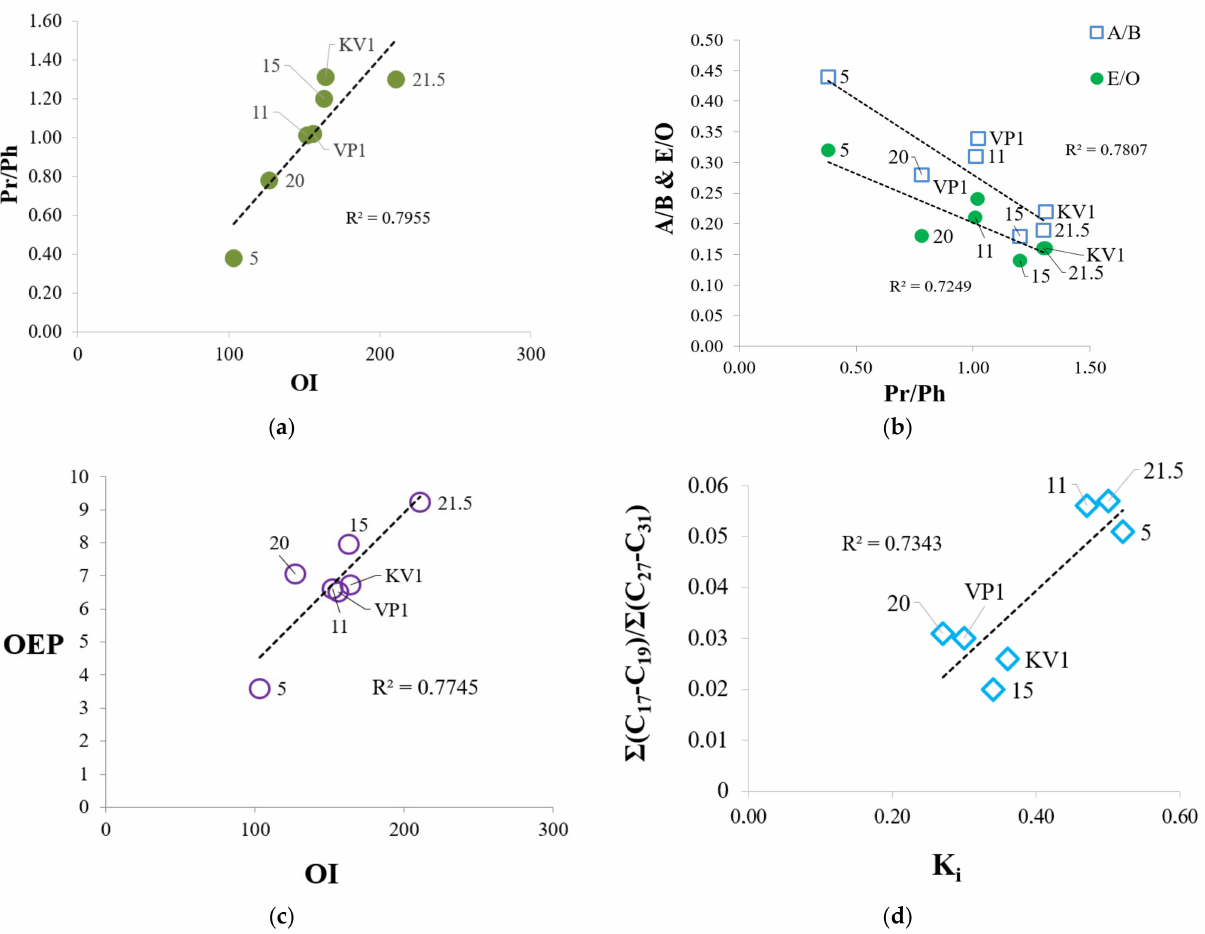
Figure 8. Relationships between Rock Eval parameters and biomarker coefficients determined from GC-MS analysis: ( a ) Relationship between OI and Pr/Ph; ( b ) dependence of A/B and E/O parameters on Pr/Ph; ( c ) dependence between OEP oddness index and OI oxygen index; ( d ) relationship between proportion of low-molecular alkanes ( Σ (C 17 -C 19 )/ Σ (C 27 -C 31 )) and K i index (K i = (Pr + Ph)/(nC 17 + nC 18